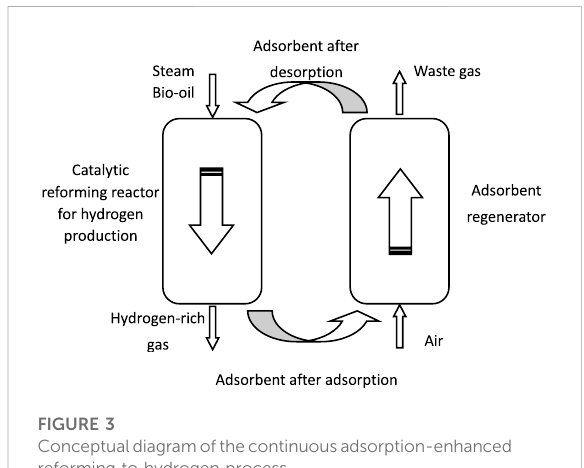
FIGURE 3 Conceptualdiagramofthecontinuousadsorption-enhanced reforming to hydrogen